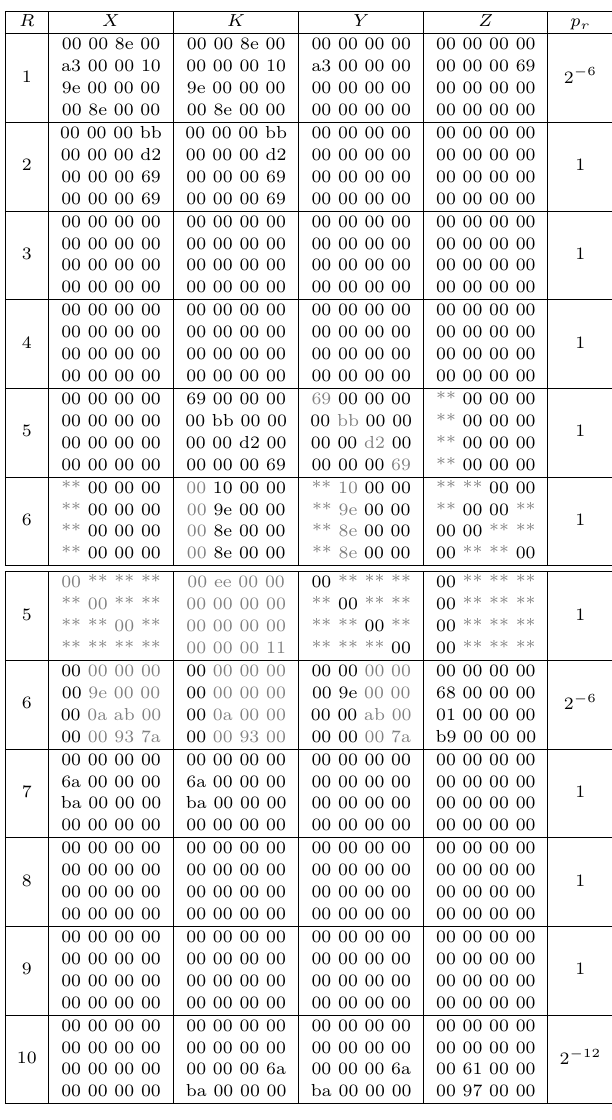
Table 11: 10-round distinguisher of Deoxys-BC-384 . The S-box switch is used in Round 6 (lower) for the S-box at position